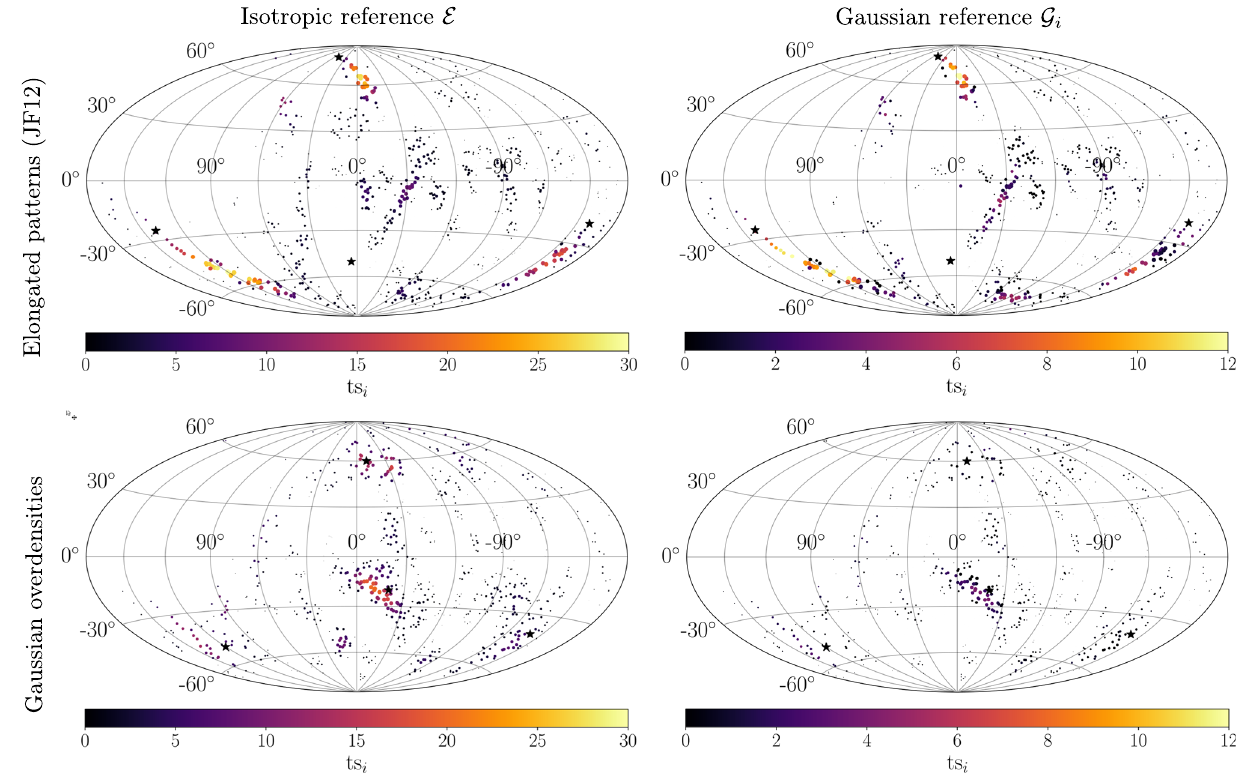
Fig. 9 Comparison of fit performance for (left) isotropic E and (right) Gaussian reference model G i , in Galactic coordinates. (Top) Bench- mark 1 simulation from Sect. 3 with N s = 20 events per source and deflection in the JF12 model. (Bottom) Gaussian overdensity with a cluster of N s = 20 events distributed around the star symbols with a